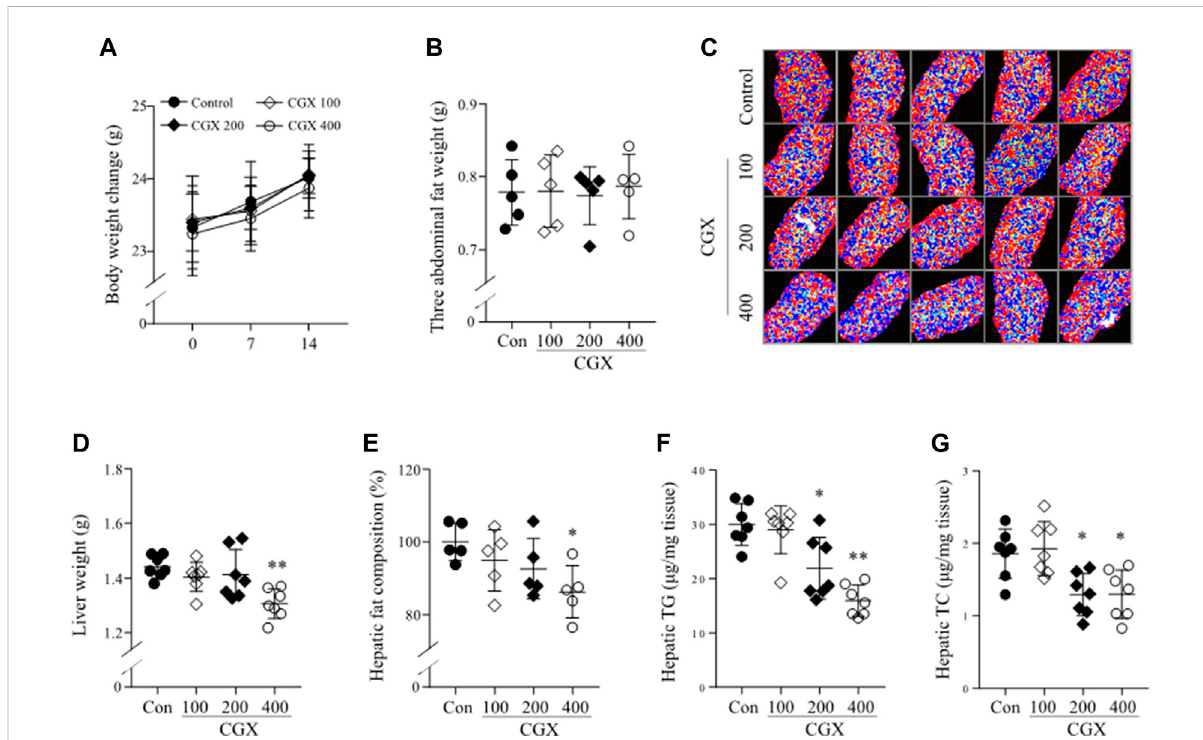
FIGURE 3 Effects of CGX on lipid components in body and hepatic tissue. Under MC38-free conditions, mice were administered with CGX (100, 200 or 400 mg/kg, 14 days). Body weight (A) was measured once a week, and the three abdominal fats (epididymal, retroperitoneal and visceral fat, (B) and liver (D) were weighed after sacri fi ce. The hepatic fat composition was measured using a DEXA analyzer and expressed as a relative value compared tothecontrolgroup (C,E) .HepaticTGandTCweredeterminedusingcommercialkits (F,G) .Thedataareexpressedasthemeans±SD( n =5or 7). * p < 0.05 or ** p < 0.01 indicates statistical signi fi cance compared to the control group. DEXA; dual energy X-ray absorptiometry, TC; total cholesterol, TG;